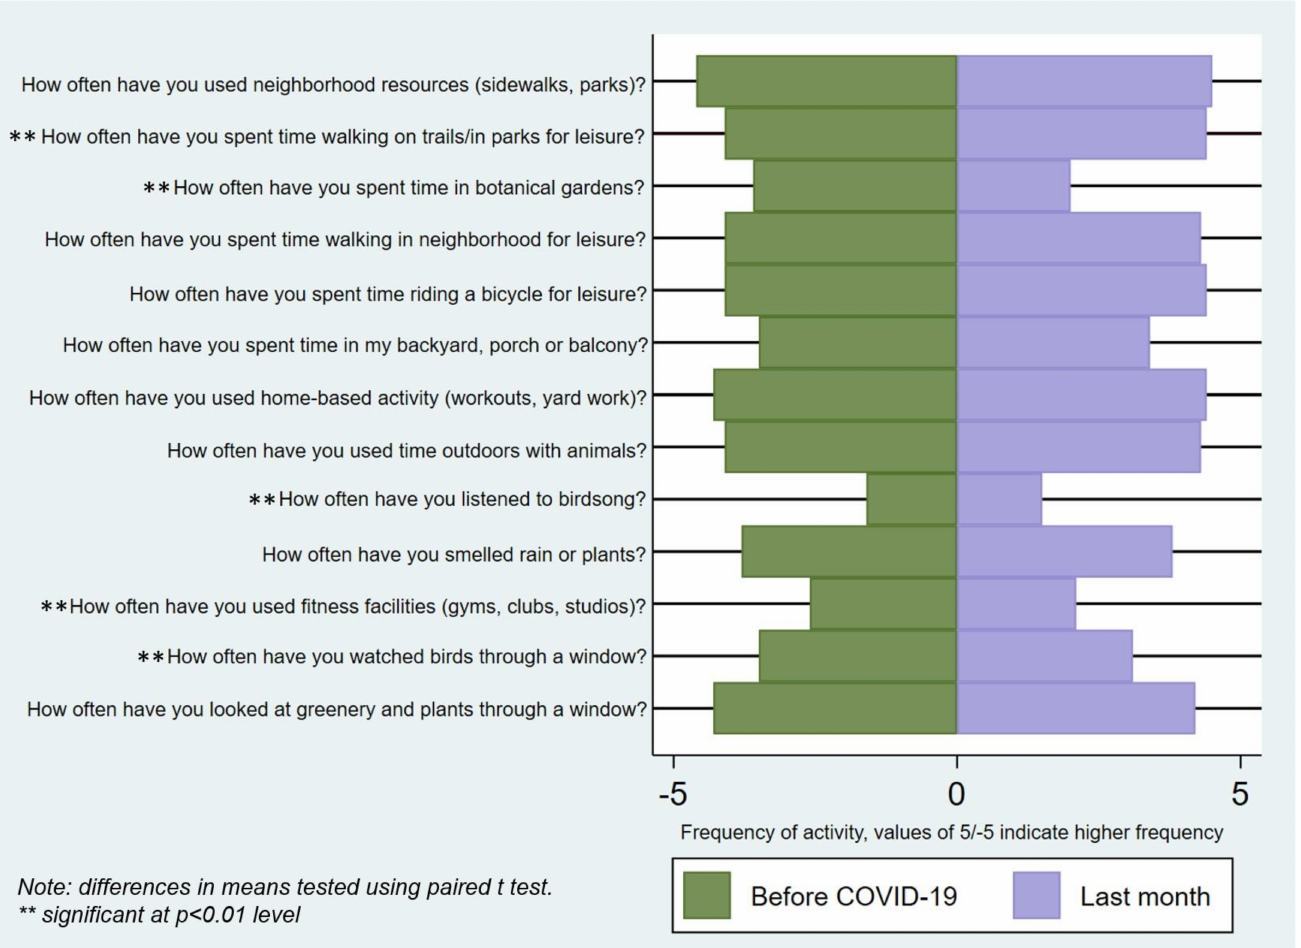
Figure 2. Changes in engagement in outdoor physical activity, usage of parks, and at-home contact with